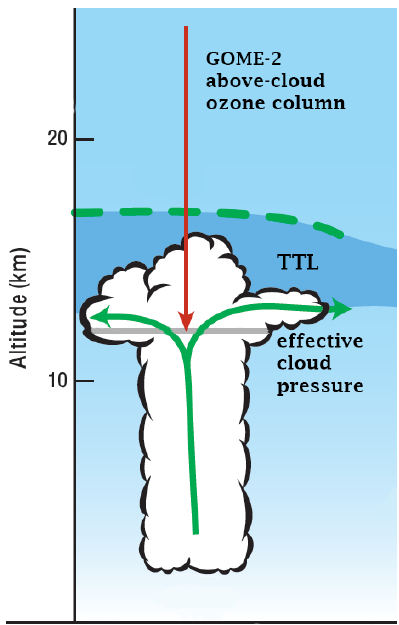
Figure 3. Schematic illustration of above-cloud ozone column mea- surements from GOME-2 for the tropics as used in the CCD tech- nique. For tropical deep convective clouds, the effective cloud pressures as determined with GOME-2 are usually between 9.5– 12.5km. TTL denotes the tropical transition layer below the tropopause (dashed green line). GOME-2 measurements with cloud fraction ≥ 0.8, cloud albedo ≥ 0.75 and cloud pressure ≤ 300hPa are used to determine the above-cloud ozone